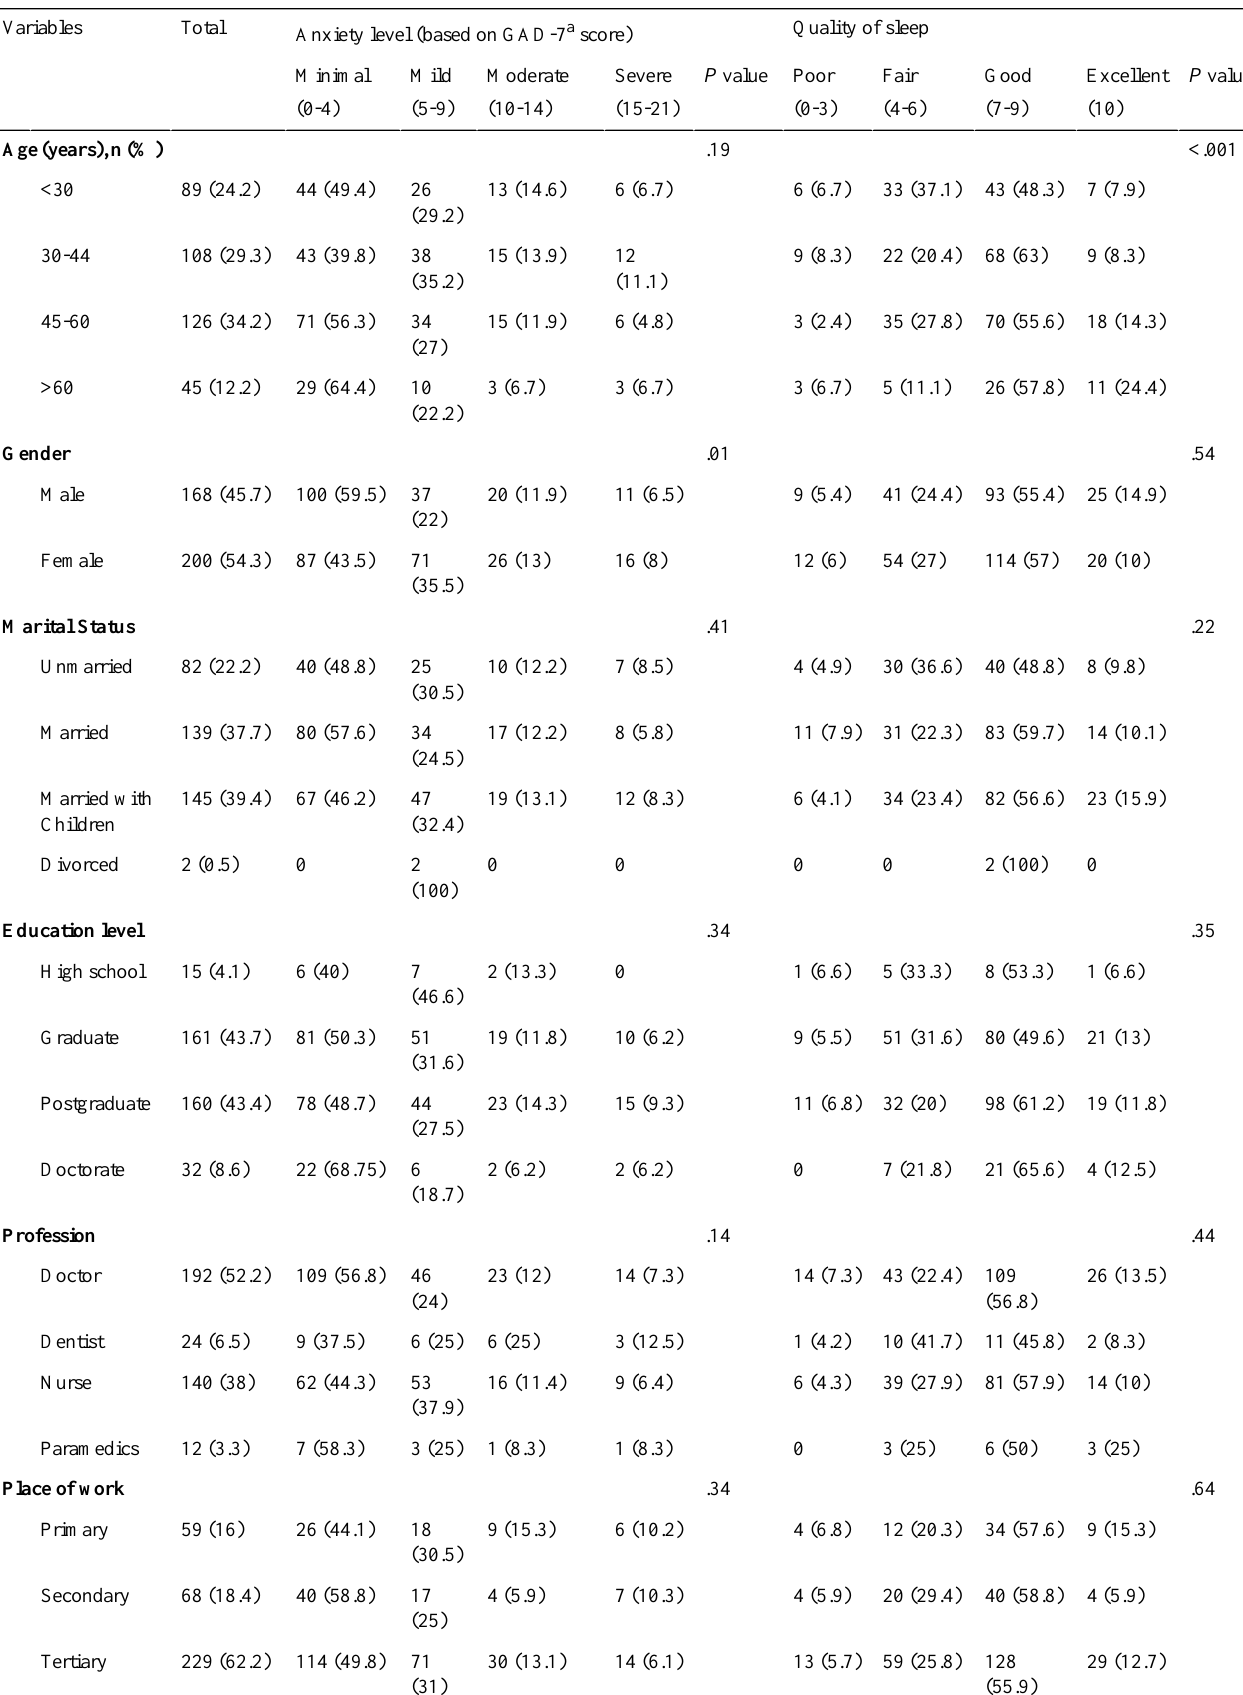
Table 3. Factors affecting anxiety and quality of sleep among health care workers (N=368).